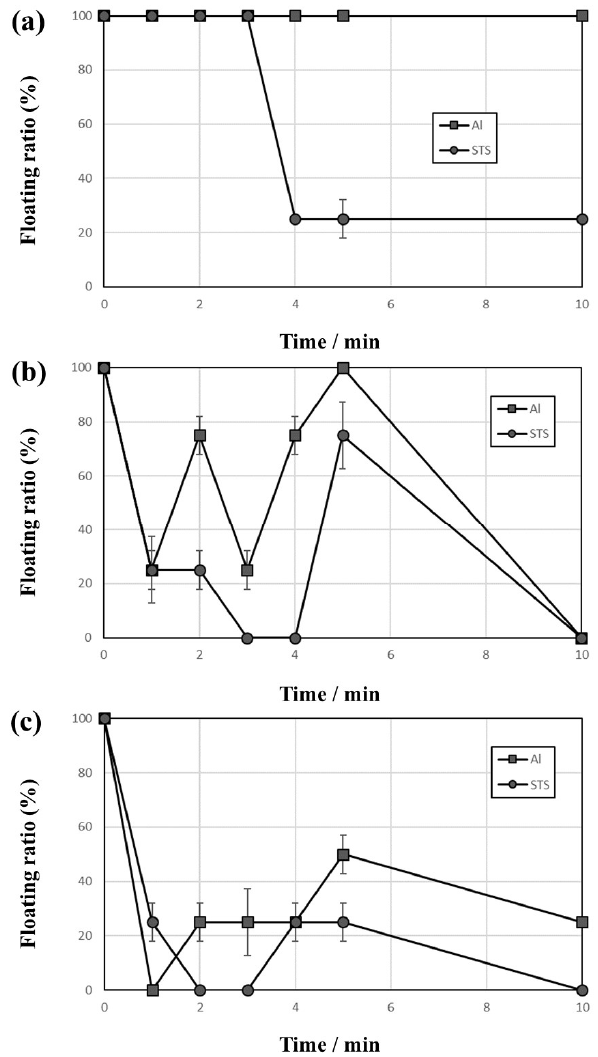
Figure 2. Floating ratio change with time of Al and stainless steel (STS) scraps during the vibrating test with vibration amplitudes of ( a ) 2, ( b ) 2.5, and ( c ) 3 mm using 1-mm zirconia balls as the medium.